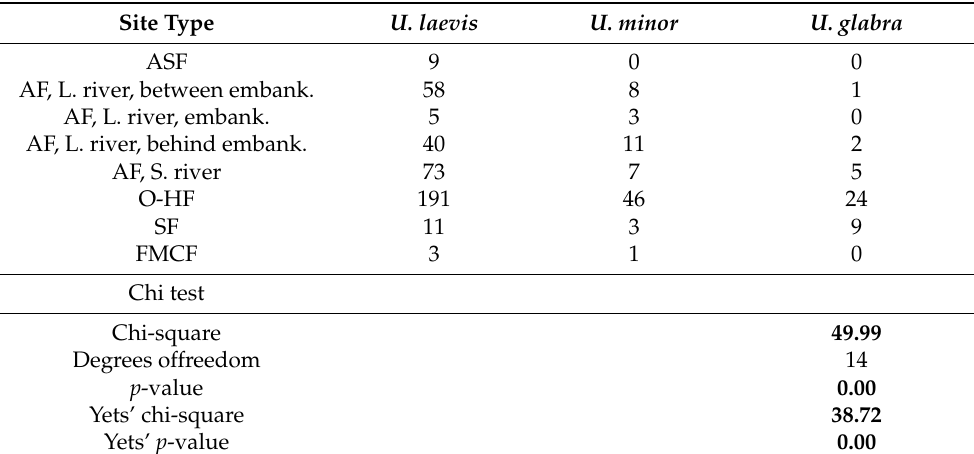
Table 4. Number of individual elm localities within the specific site types distinguished in the field (topographic classification) and chi-square test.